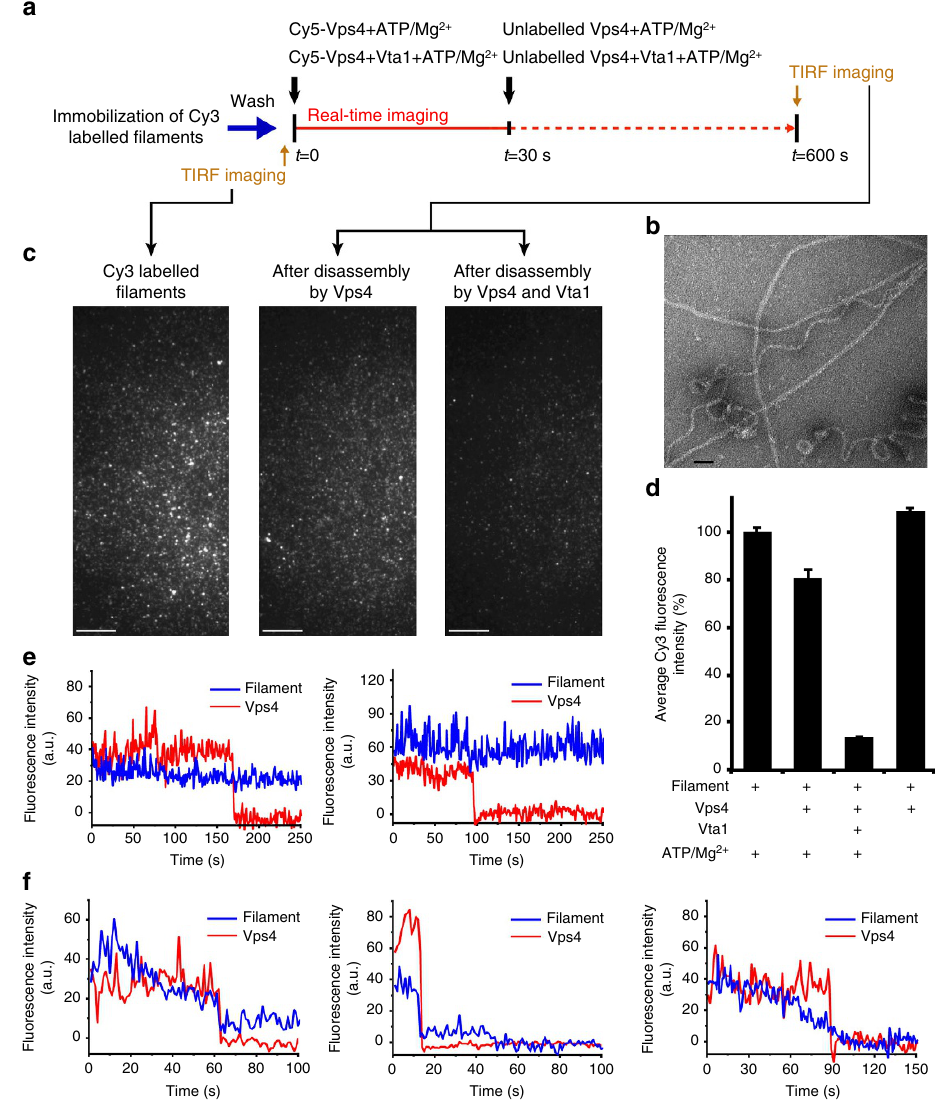
Figure 4 | Single-molecule fluorescence assay of the ESCRT-III filament disassembly by Vps4 alone or by Vps4 together with Vta1. ( a ) Procedure of the single-molecule total internal reflection fluorescence (TIRF) microscope experiment. ( b ) Negative staining EM micrograph of the ESCRT-III filaments. Scale bar, 50 nm. ( c ) TIRF microscopy images of Cy3 fluorescence channel representing ESCRT-III filaments after immobilization (left), after disassembly by Vps4 (middle) and after disassembly by Vps4 and Vta1 (right). Scale bar, 10 m m. ( d ) The average Cy3 fluorescence intensities associated with filaments under various conditions of the disassembly reaction. Data are represented as the average of three independent experiments. Error bars represent s.e.m. ( e , f ) Single-molecule fluorescence trajectories of Cy5-Vps4 and Cy3-filament during the filament disassembly. ( e ) Cy5-Vps4 disappeared while almost no changes were observed in the filament coupled Cy3 fluorescence intensity. ( f ) Cy5-Vps4 disappeared while the filament coupled Cy3 fluorescence intensity was also